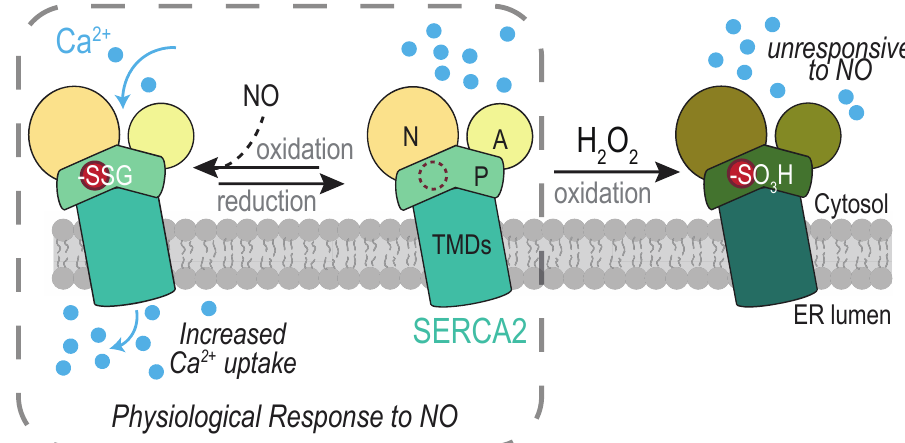
Figure 6. Mammalian SERCA2 oxidation at the cytosolic Cys674 modulates Ca 2+ uptake into the ER in response to nitric oxide (NO). Cys674 (red circle) is located within the SERCA2 P domain, between the nucleotide binding domain (N) and the transmembrane domains (TMDs). The presence of NO in combination with cellular ROS and reduced glutathione results in SERCA2 glutathionylation (–SSG) and increased pumping of Ca 2+ from the cytosol into the ER lumen. An accumulation of sulfonylated SERCA2 (–SO 3 H) is associated with a lack of responsiveness to NO and various disease pathologies, including artherosclerosis. A, actuator domain.